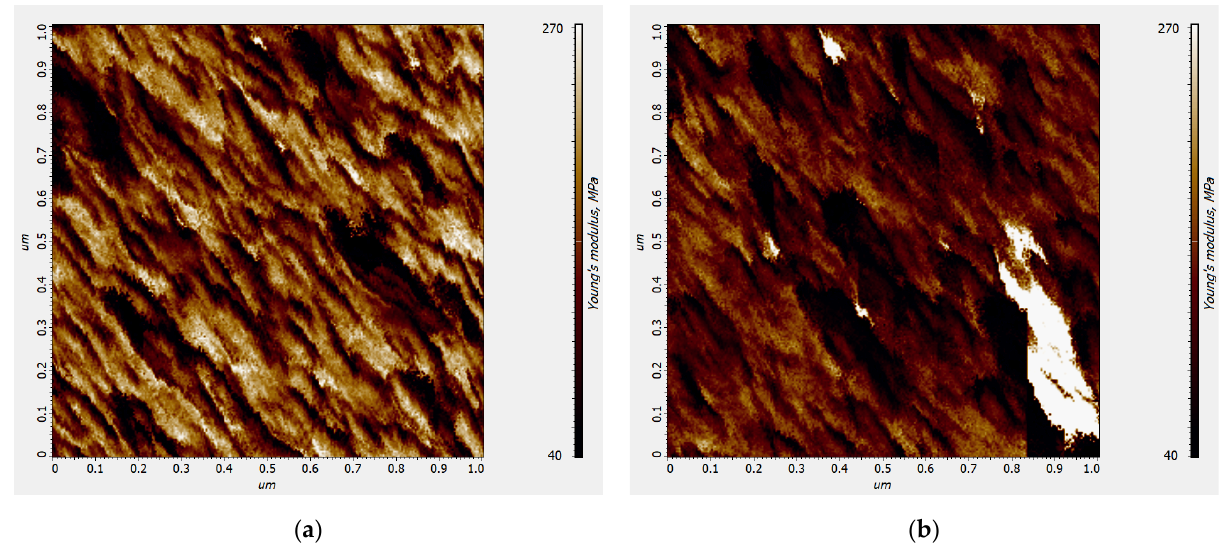
Figure 5. The maps of Young’s modulus of the poly[NiSalphen] film in 0.1 M Et 4 NBF 4 /PC in the uncharged ( a ) and charged ( b ) states acquired by EC-HD QNM AFM.